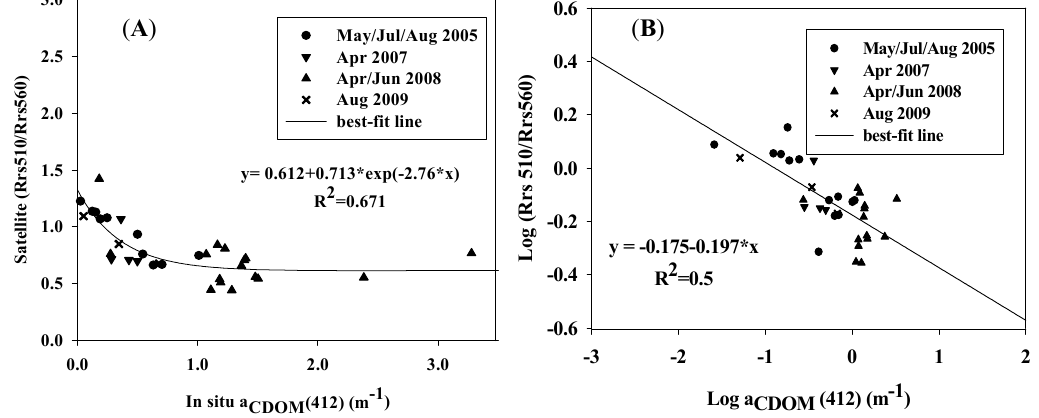
band ratio (510 nm and 560 nm) plotted against in situ surface Figure 8. MERIS-derived R rs CDOM absorption at 412 nm ( A ) exponential decay model and ( B ) logarithmic model .